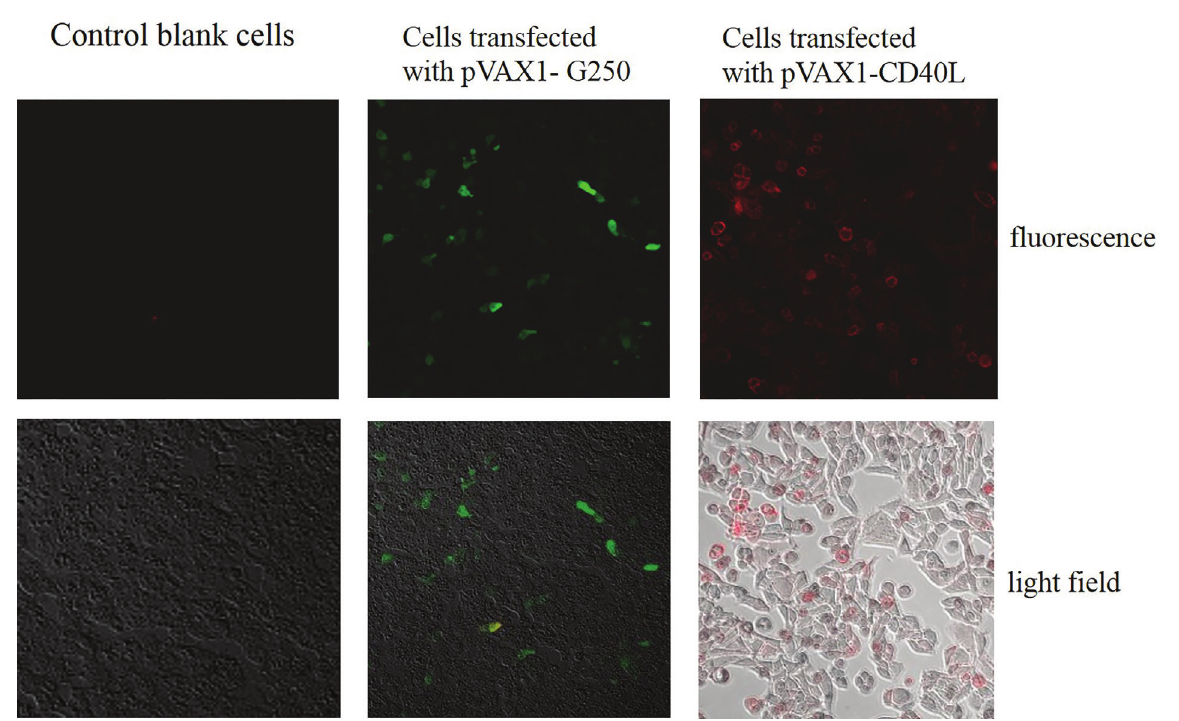
FIGURE 2 - Expression of the recombinant plasmid DNA in 293T cells by immunofluorescence analysis. with both pVAX1-G250 and pVAX1-CD40L than in those of pVAX1-G250 group